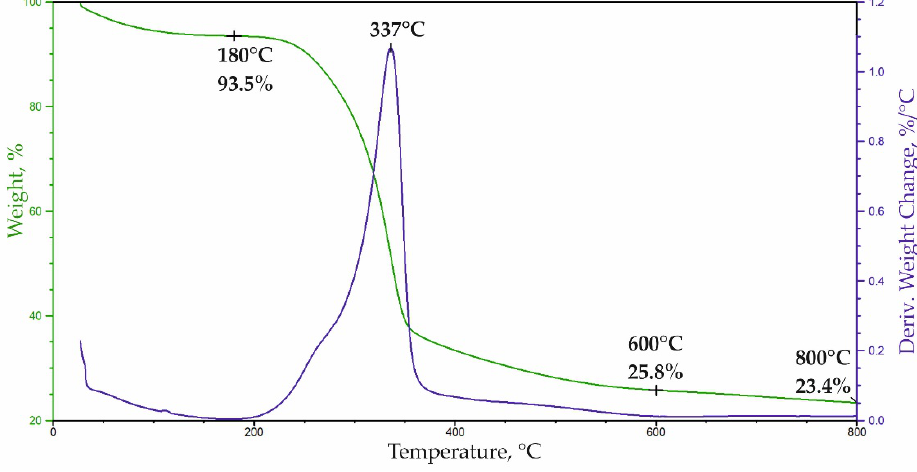
Figure 4. TGA analysis of ARBOCEL ® P 4000 X.